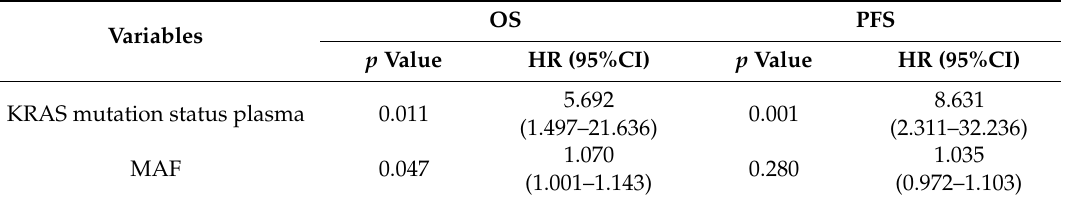
Table 4. Multivariate Analysis.